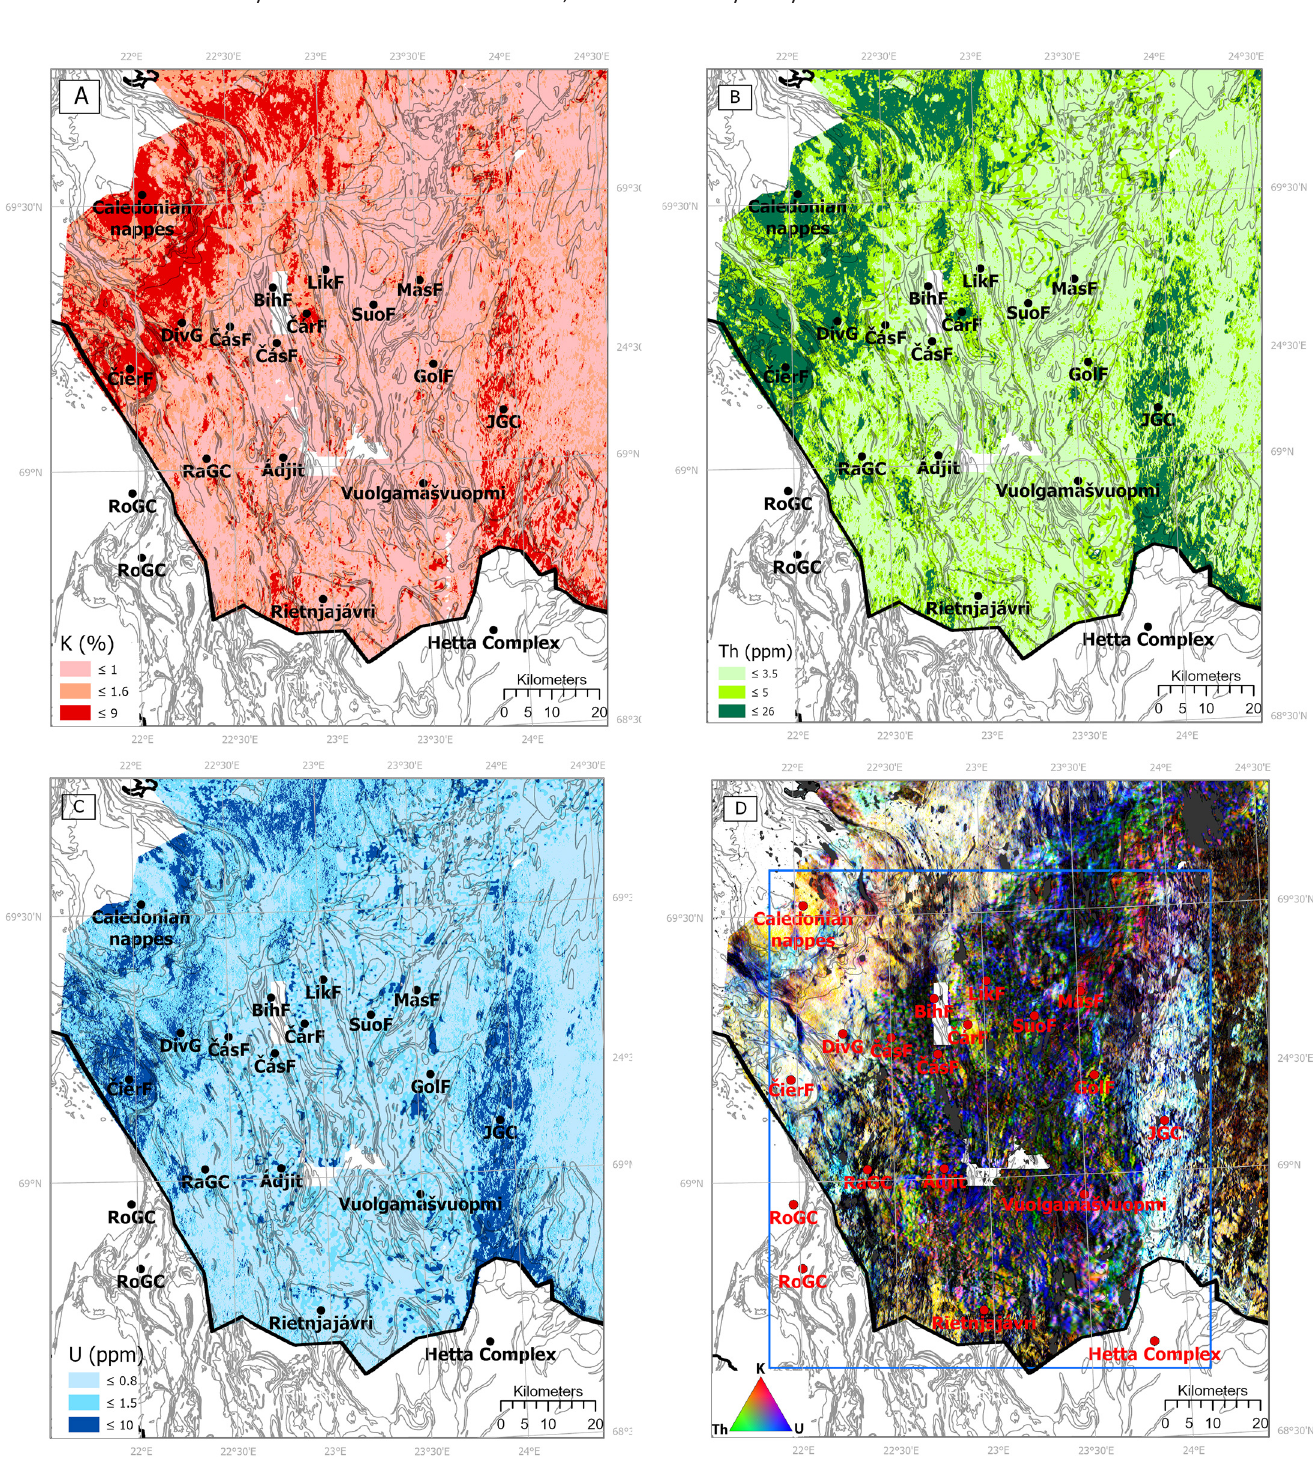
Figure 11. Radiometry data. (A) Potassium concentration (%). (B) Thorium (ppm). (C) Uranium (ppm). (D) Ternary map consisting of potassium (red), uranium (blue) and thorium (green). The blue frame outlines the 3D modelled area. BihF= Bihkkačohkka Formation, ČárF= Čáravárri Formation, ČásF= Čáskejas Formation, ČierF= Čierte Formation, DivG= Dividal Group, GolF= Goldenvárri Formation, JGC= Jergul Gneiss Complex, LikF= Likčá Formation, MasF= Masi Formation, RaGC= Ráiseatnu Complex, RoGC= Rommaeno Gneiss Complex, SuoF= Suolovuopmi